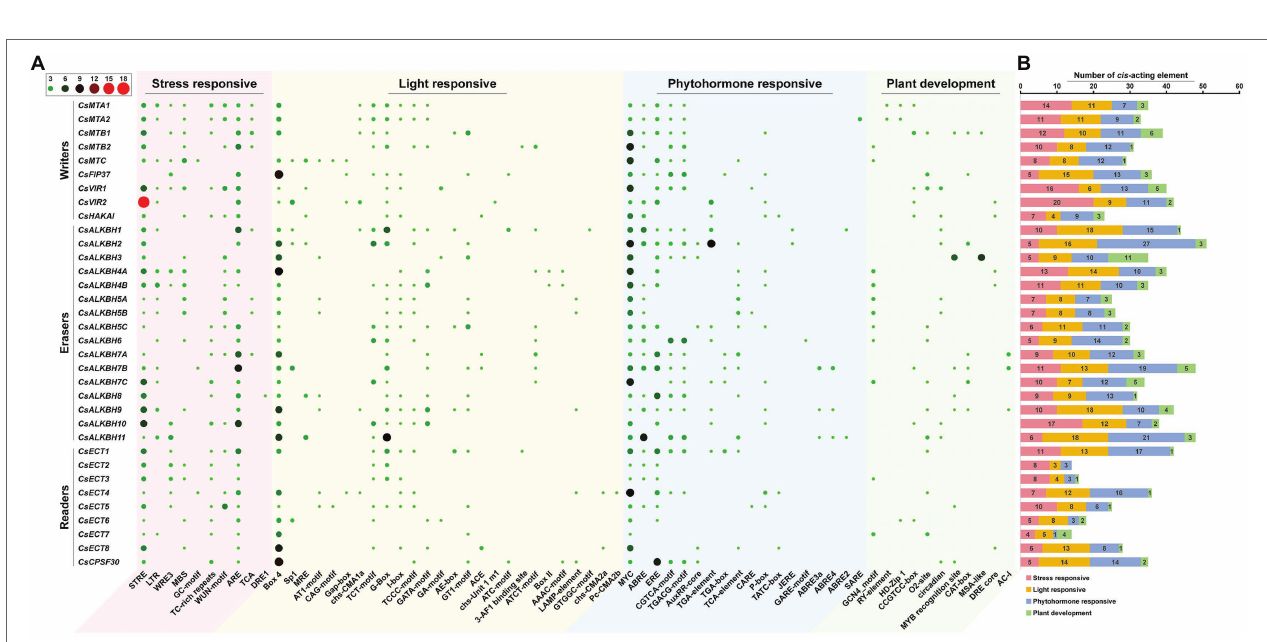
FIGURE 6 | Functional protein–protein interaction network of the m6A regulatory proteins in tea plants. The protein–protein interaction network of m6A regulatory proteins was constructed using the STRING v11.0 database. The orthologous protein was found using Tea Plant Information Archive (TPIA) database, and further, the homologous proteins were also considered as STRING proteins based on the high bit score.